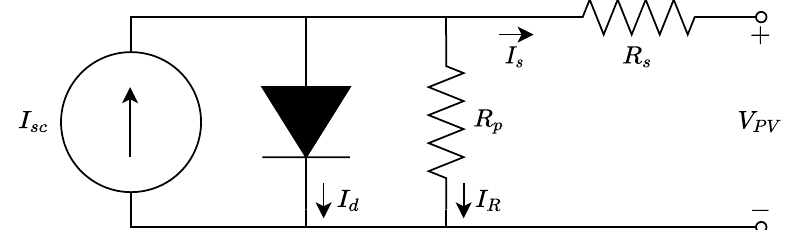
Figure 2. The single-diode model of a PV